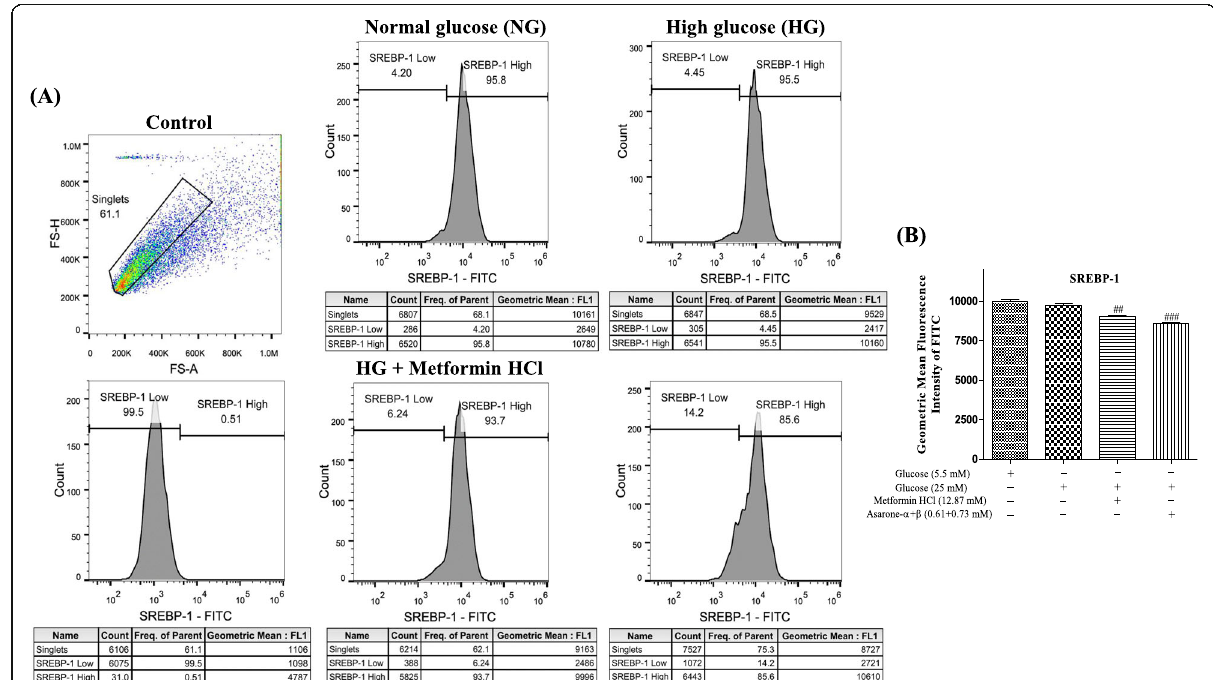
Fig. 5 The treatment of high glucose-promoted HepG2 cells with metformin and asarone downregulates the expression of SREBP-1. a A representative flow cytometry histogram events depicting the expression of SREBP-1 cultured in normal glucose (NG; 5.5 mM), high glucose (HG; 25 mM), HG + Metformin HCl, and HG + Asarone. b Bar diagrams represent geometric mean fluorescence intensity (GMFI) of SREBP-1 in HepG2 cells. Values represent mean ± SEM of an experiment done in triplicate; one-way ANOVA followed by Bonferroni test, where ## p < 0.01 and ### p < 0.001 compared to the high glucose (HG)